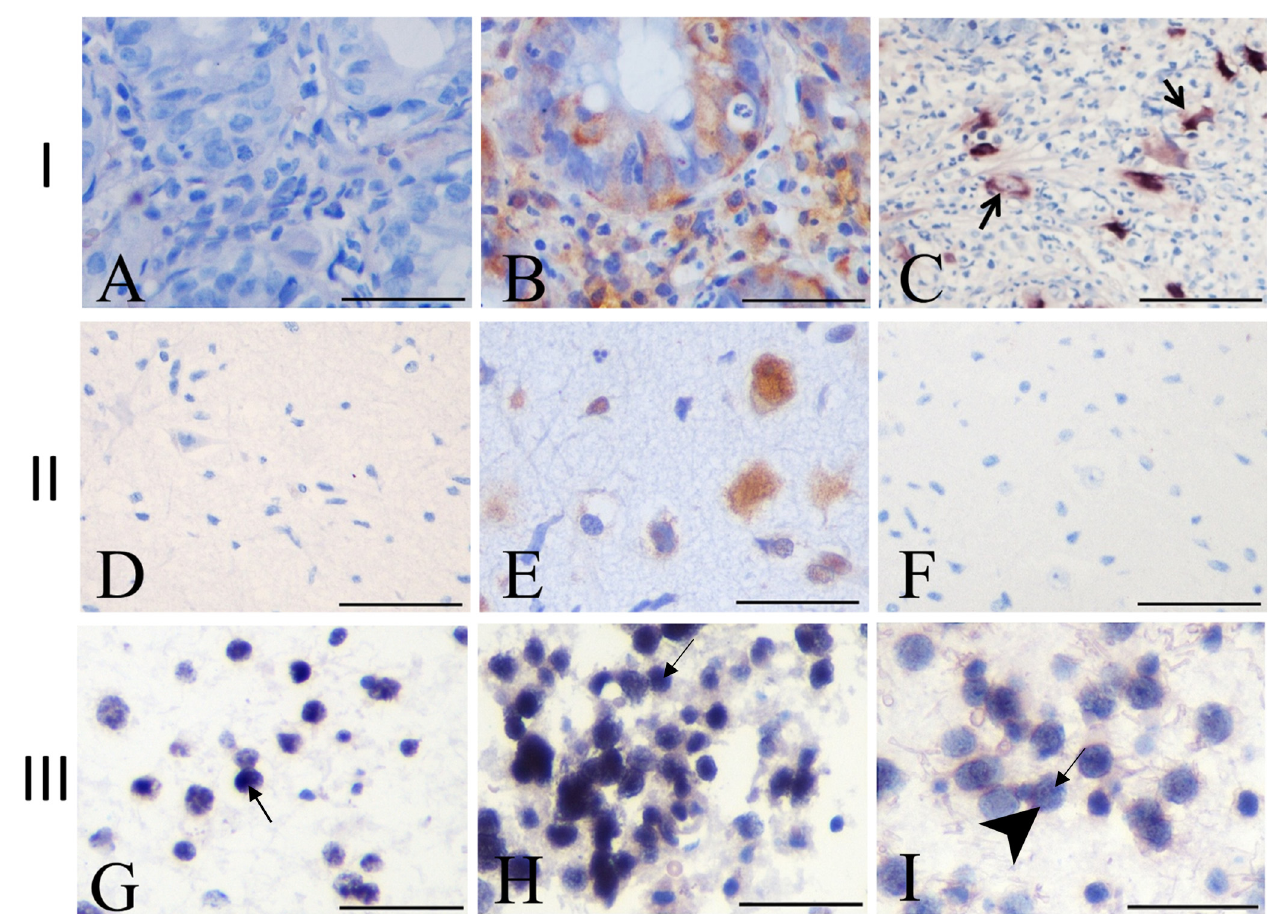
Fig 3. Insitu hybridization in gliomas. Row I: Infected HCMV colon tissue. (A) No probe. (B) Polyadenylic RNA probe. (C) HCMV 2.7 RNA probe. Row II: Non-tumoral brain. (D) No probe. (E) Polyadenylic RNA probe. (F) HCMV 2.7 RNA probe. Row III: Positive tumor samples. (G) AST I, score 4. (H) ODG II, score 12. (I) AST II, score 6. Arrows indicate nuclear signal in neoplastic cells (dark blue). In I, arrowhead and arrow indicate cytoplasmic and nuclear signal (blue). All samples were counterstained with Eosin. Scale bar = 10 μ